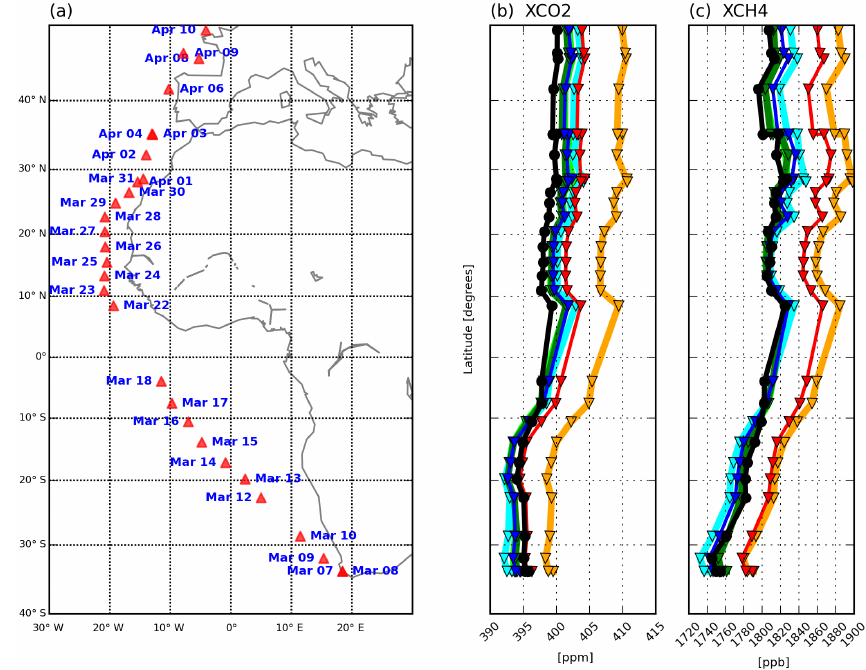
Figure 7. (a) Map showing the daily mean sampling location of Polarstern cruise. (b, c) Comparisons of latitudinal distribution of XCO 2 and XCH 4 as derived from monthly mean (7 March to 10 April) Polarstern observations (black) and simulations using different mass fixers at different resolutions: red and orange lines denote without mass fixer at low and high resolutions respectively; blue and cyan lines with the proportional mass fixer at low and high resolutions respectively; and green and light green with the Bermejo–Conde fixer and low and high resolutions respectively. See Table 1 for a more detailed description of the experiments. Table 5. XCH 4 inter-hemispheric gradient (IHG) error (MODEL − OBS) statistics for simulations with different resolution and different mass fixers with respect to observations from the Polarstern